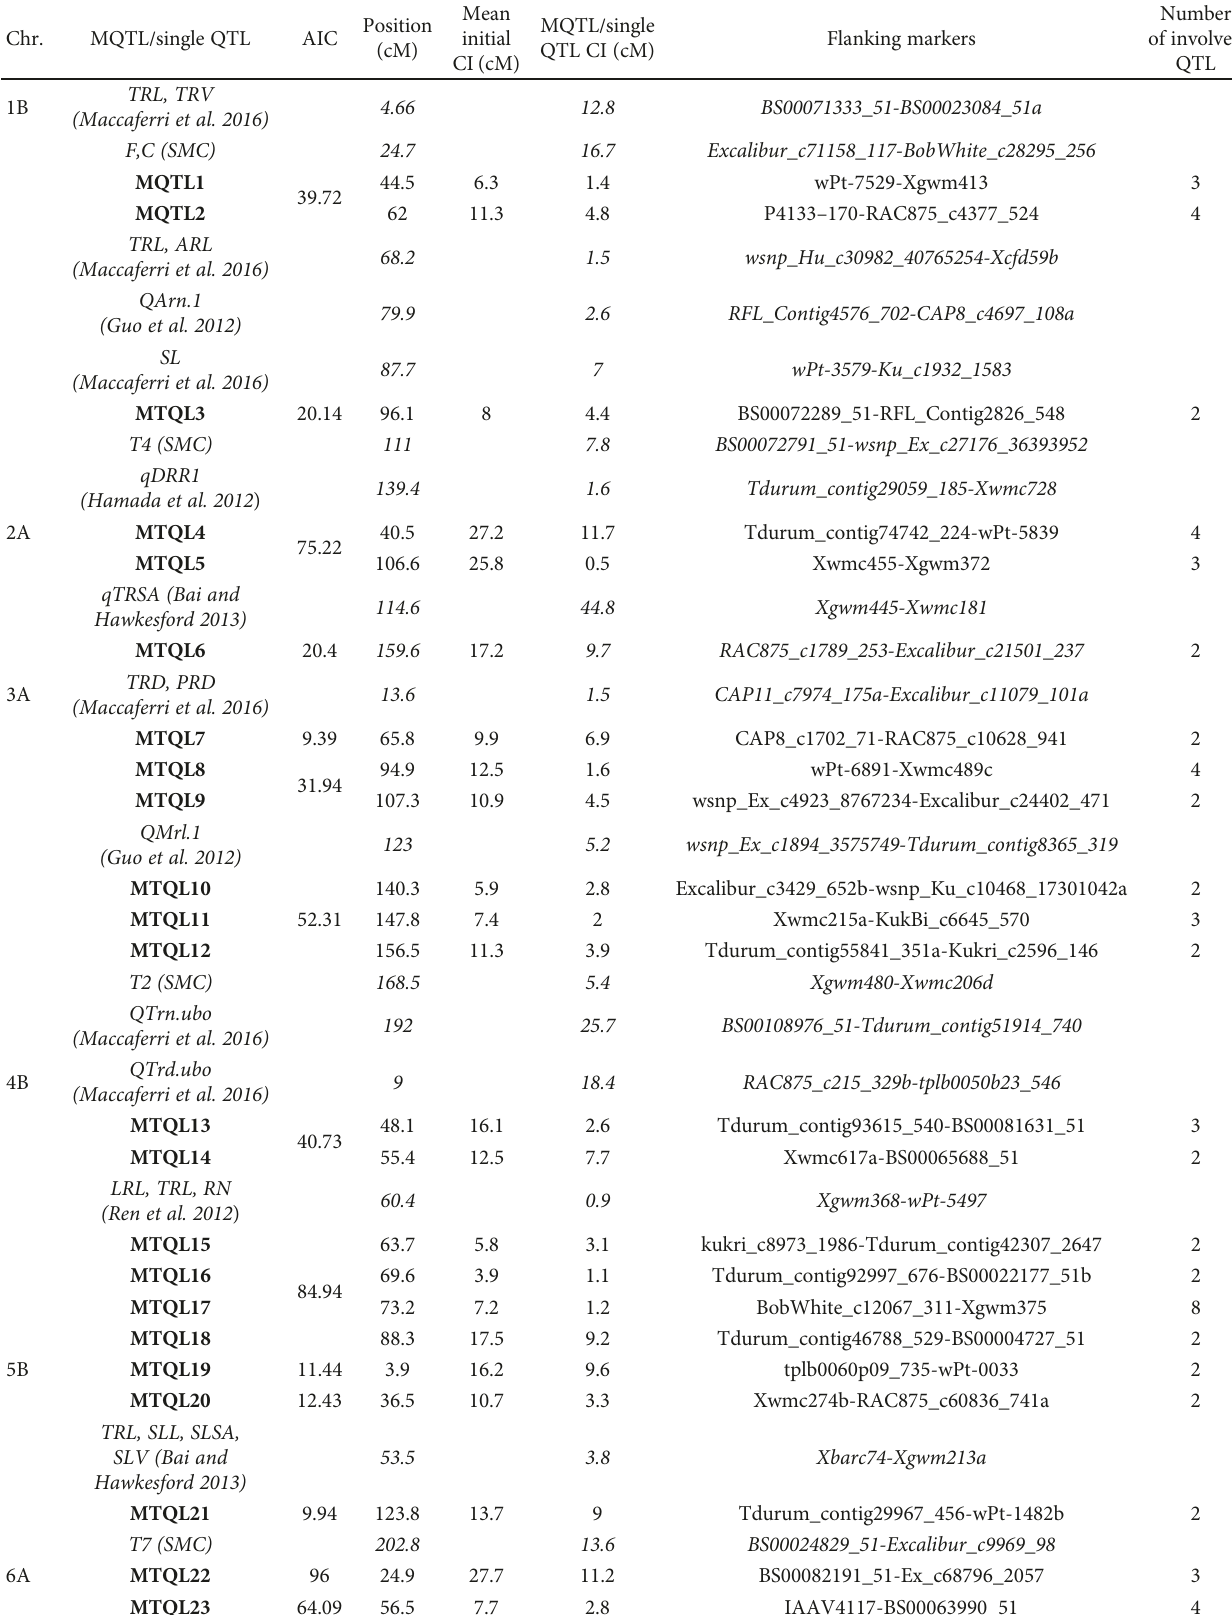
Table 4: Characteristics of the MQTL (in bold) and single QTL (in italics) identi fi ed in the meta-analysis in the present study.